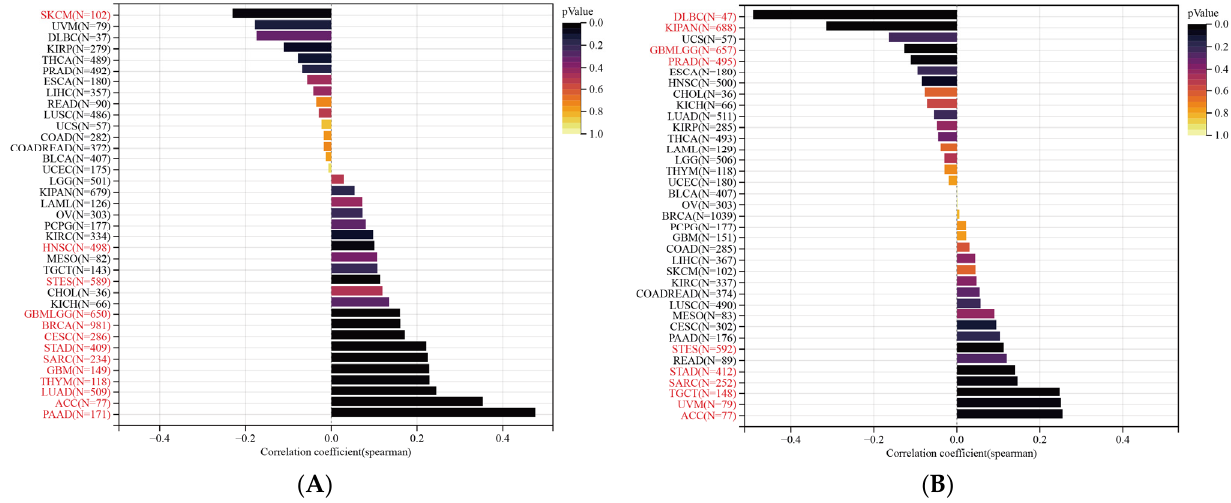
Figure 15. Correlation of SLC2A1 expression with TMB ( A ) and MSI ( B ) in pan-cancer.